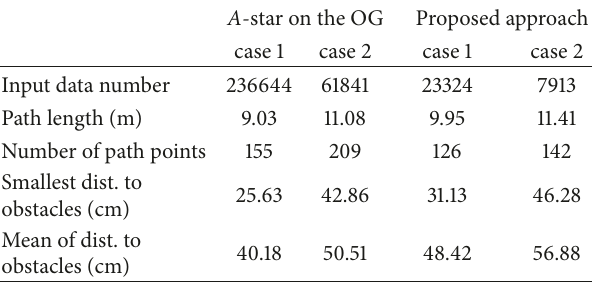
Table2:Quantitativecomparisonbetweenthe A -starappliedonthe OG and the proposed approach based on two different UAV sizes ( 𝛿 = 20 cm (case 1), 𝛿 = 40 cm (case